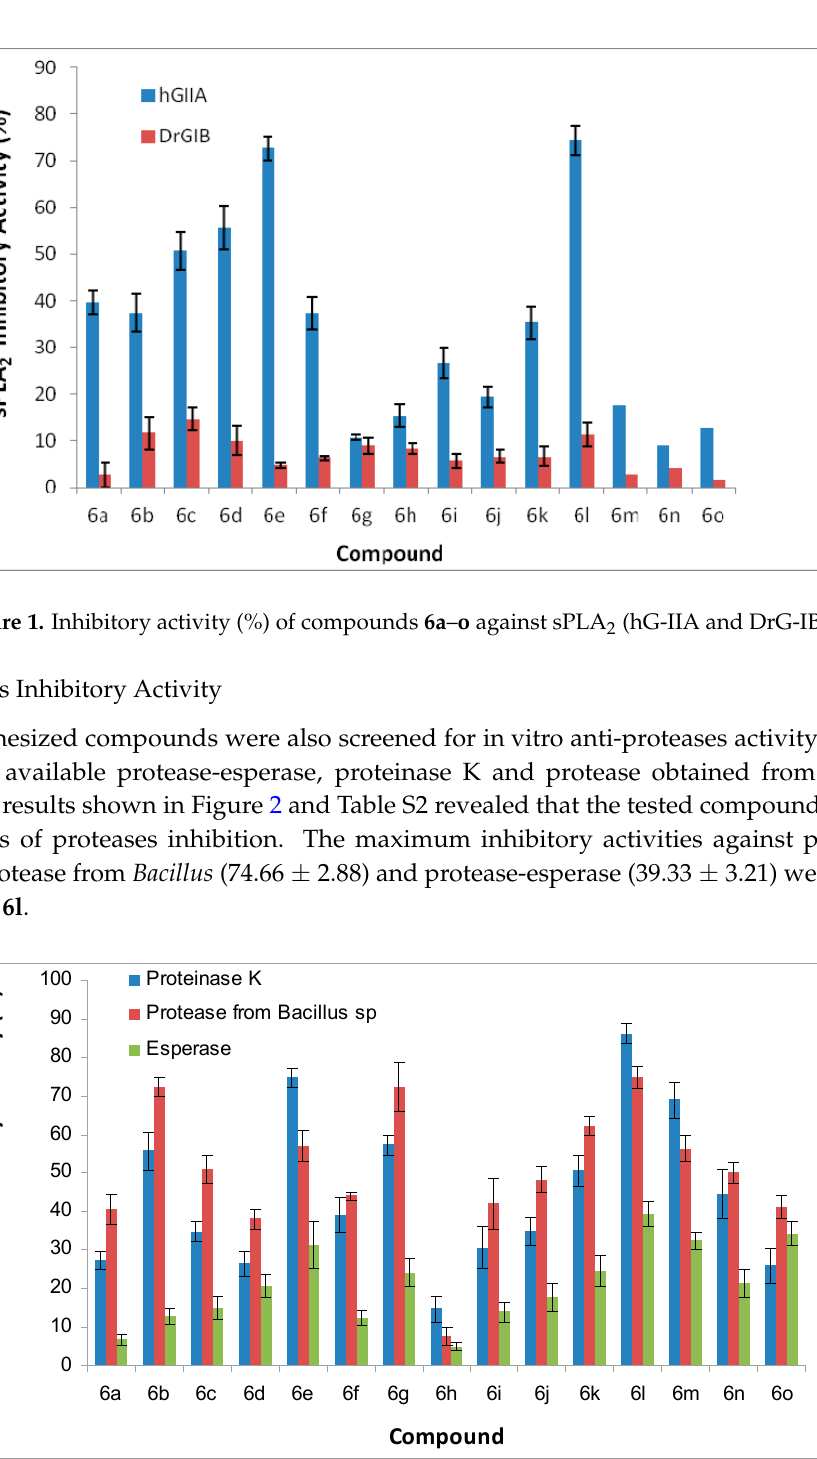
Figure 2. Antiprotease activity (%) of compounds 6a – o against different protease enzymes.